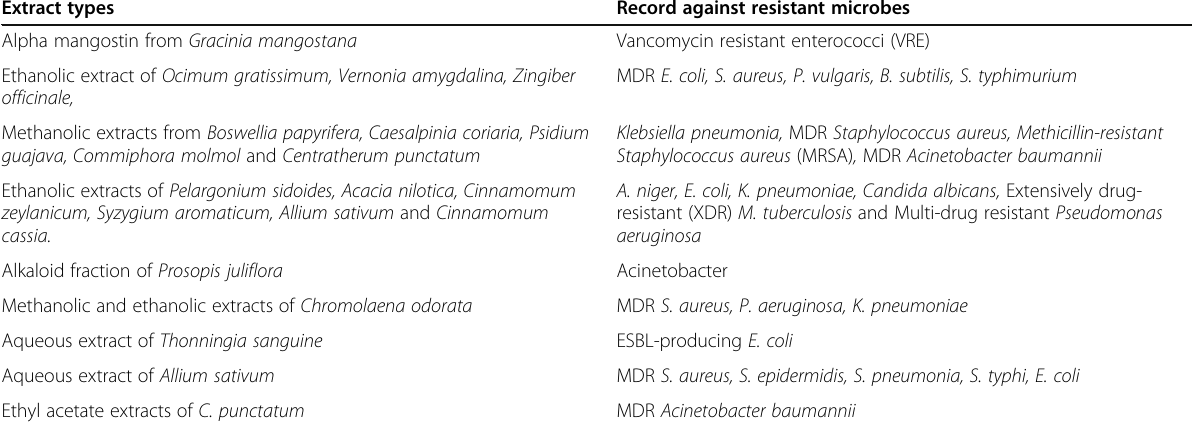
Table 2 Overview of extracts with efficacy against resistant microorganisms Extract